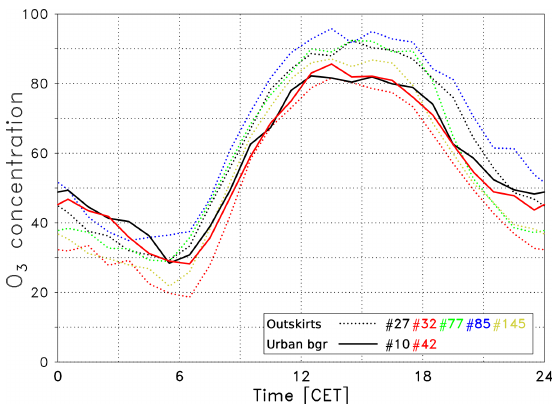
Figure 10. Diurnal cycle of O 3 concentrations (in µgm − 3 ) at five stations at the outskirts (dotted lines) and two urban background stations (solid) as given in the legend (see also Table 1). Medians of the concentrations are plotted.